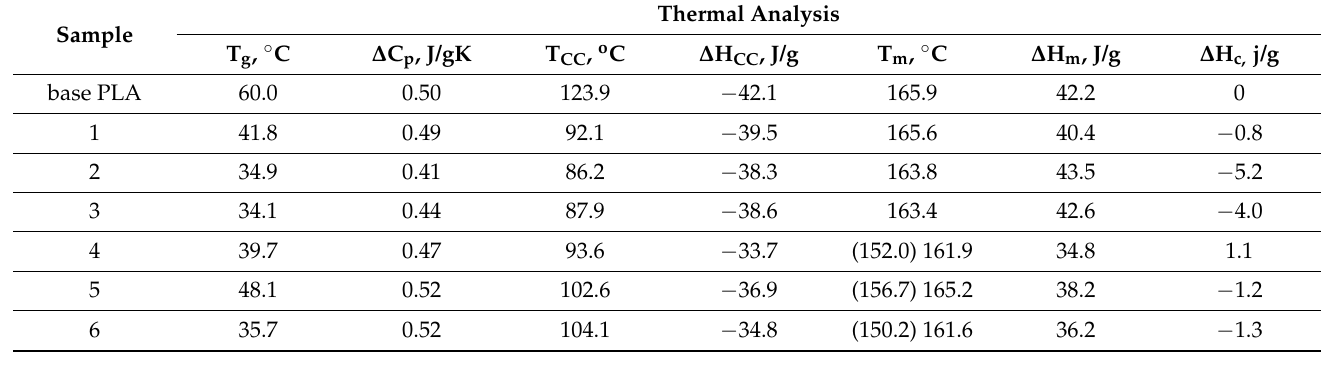
Table 2. Thermal analysis parameters of base and plasticized PLA.